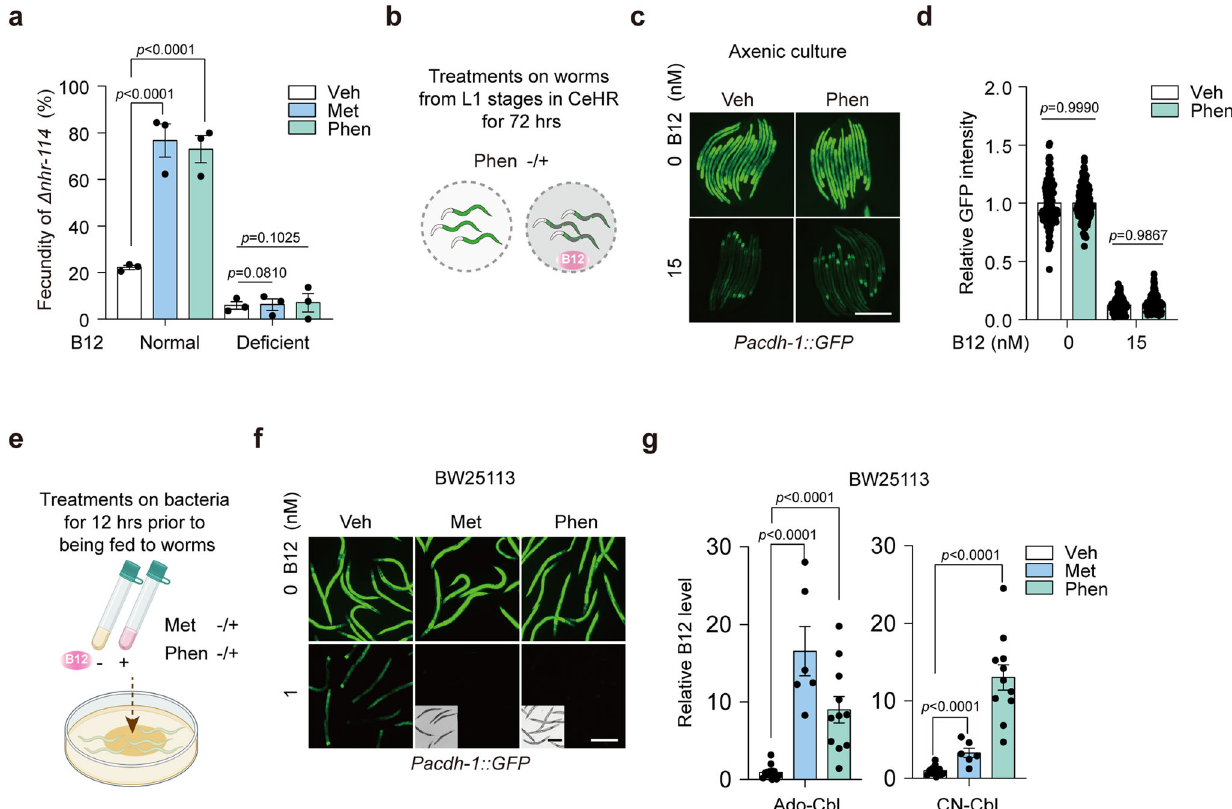
Fig. 1 The antidiabetic biguanides promote bacterial B12 accumulation. a Fecundity of Δ nhr-114 animals on normal NGM plates or B12-de fi cient NGM plates treated with 50 mM metformin/5 mM phenformin. Veh, vehicle. Met, metformin. Phen, phenformin. N = 3 independent experiments containing at least 30 worms per group. b Scheme of treatments on worms in axenic culture treated with B12 and/or phenformin. c Representative images of Pacdh- 1::GFP worms supplemented with B12 and/or 4 mM phenformin in axenic culture. d Quanti fi cation of relative GFP intensity of Pacdh-1::GFP worms in ( c ). N = 3 independent experiments containing at least 30 worms per condition. e Scheme of treatments on BW25113 to feed Pacdh-1::GFP worms. f Representative images of Pacdh-1::GFP worms fed with BW25113 pretreated with B12 and/or 200 mM metformin/4 mM phenformin. N = 3 independent experiments containing at least 30 worms per condition. Scale bar: 250 μ m ( fl uorescence images) and 500 μ m (bright fi eld images) for ( c ) and ( f ). g LC- MS/MS measurement of B12 levels in BW25113 treated with 200 mM metformin/4 mM phenformin. Ado-Cbl, adenosylcobalamin; CN-Cbl, cyanocobalamin. N = 2 independent experiments for the metformin groups and N = 3 independent experiments with at least 3 single colonies per test. The statistical signi fi cance values were determined by ordinary one-way ANOVA for ( a ) and ( d ) and unpaired t test for ( g ). Error bars denoted the